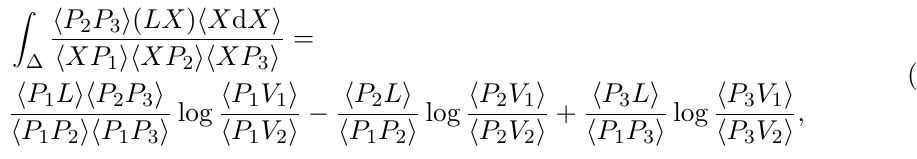
Note the symbol is defined to satisfy the same algebraic relations as the log. In (2.10)